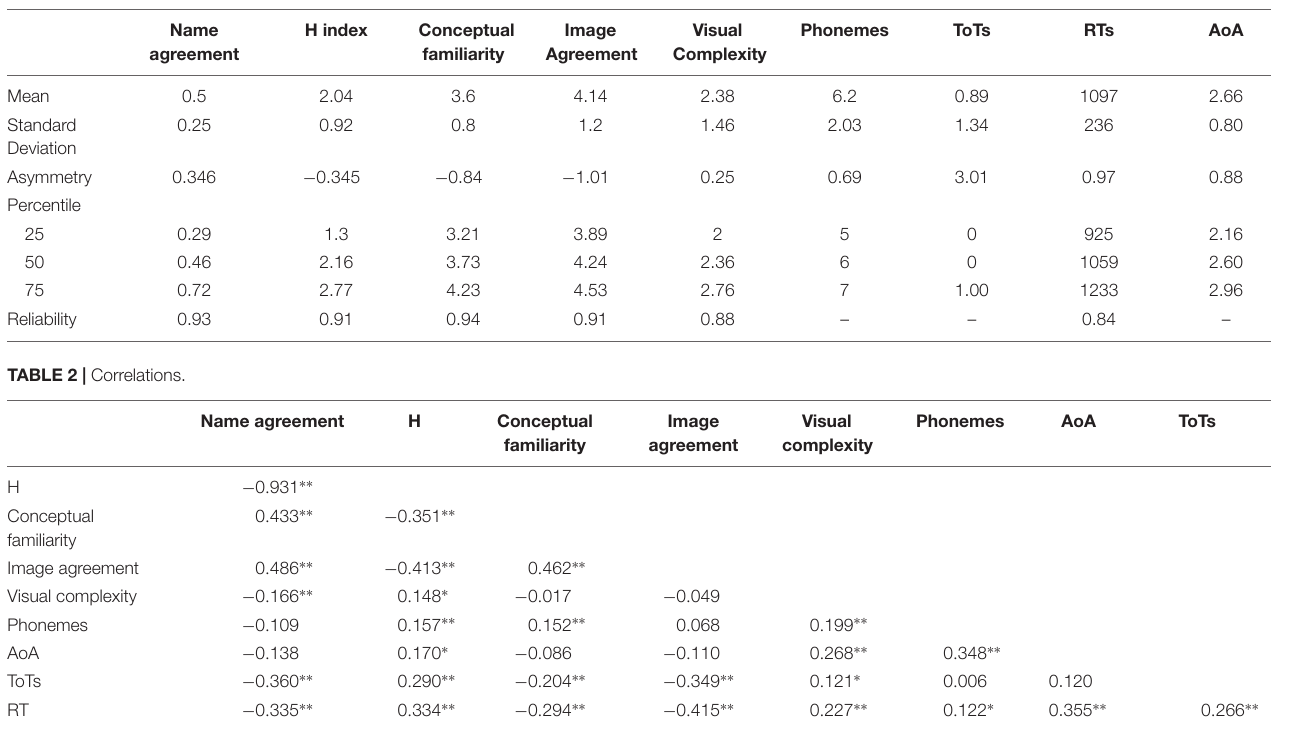
TABLE 1 | Descriptive statistics in the normative